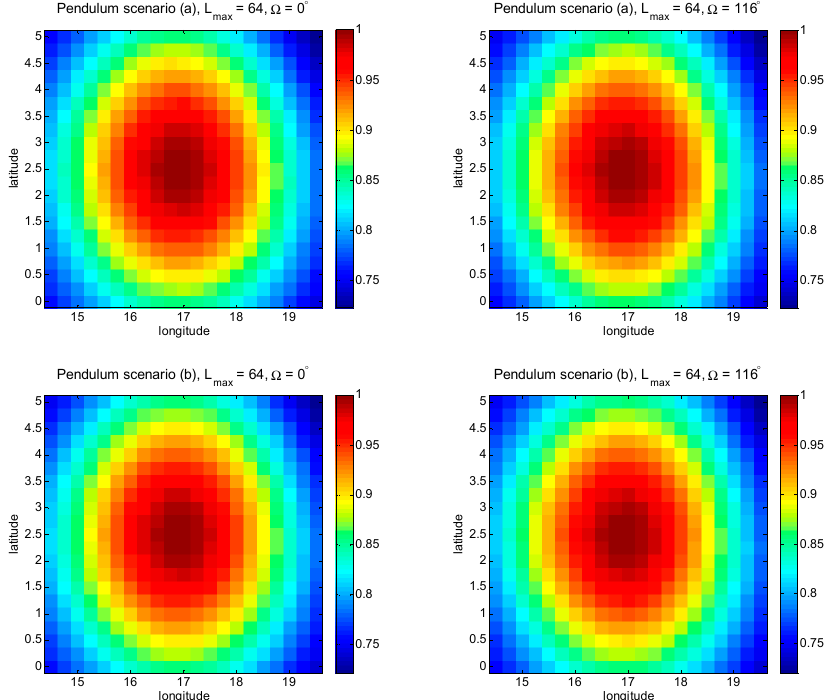
Figure 26. Spatial covariance of a selected point in West Africa (from Figures 19 and 20) for 6-day solution of the Pendulum formation up to L max = 64, for top : scenario (a), and bottom : scenario (b). Left is Ω = 0° and right is Ω = 116°.